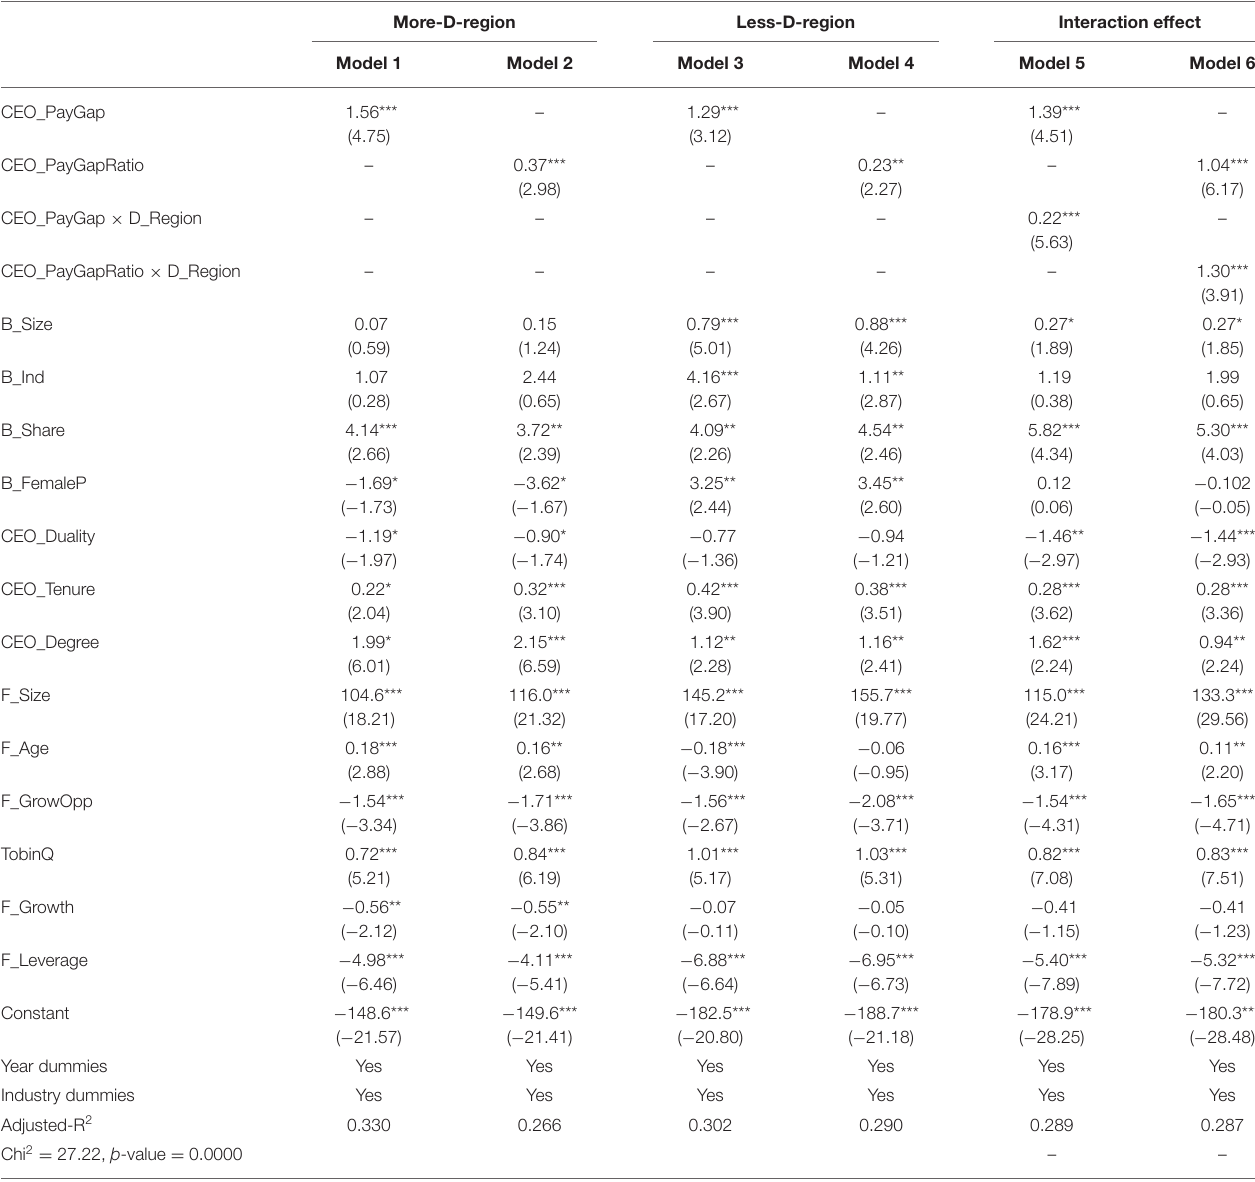
TABLE 5 | CEO tournament incentive and corporate social responsibility performance (sub-sample more-developed-region vs. less-developed-region) and interaction